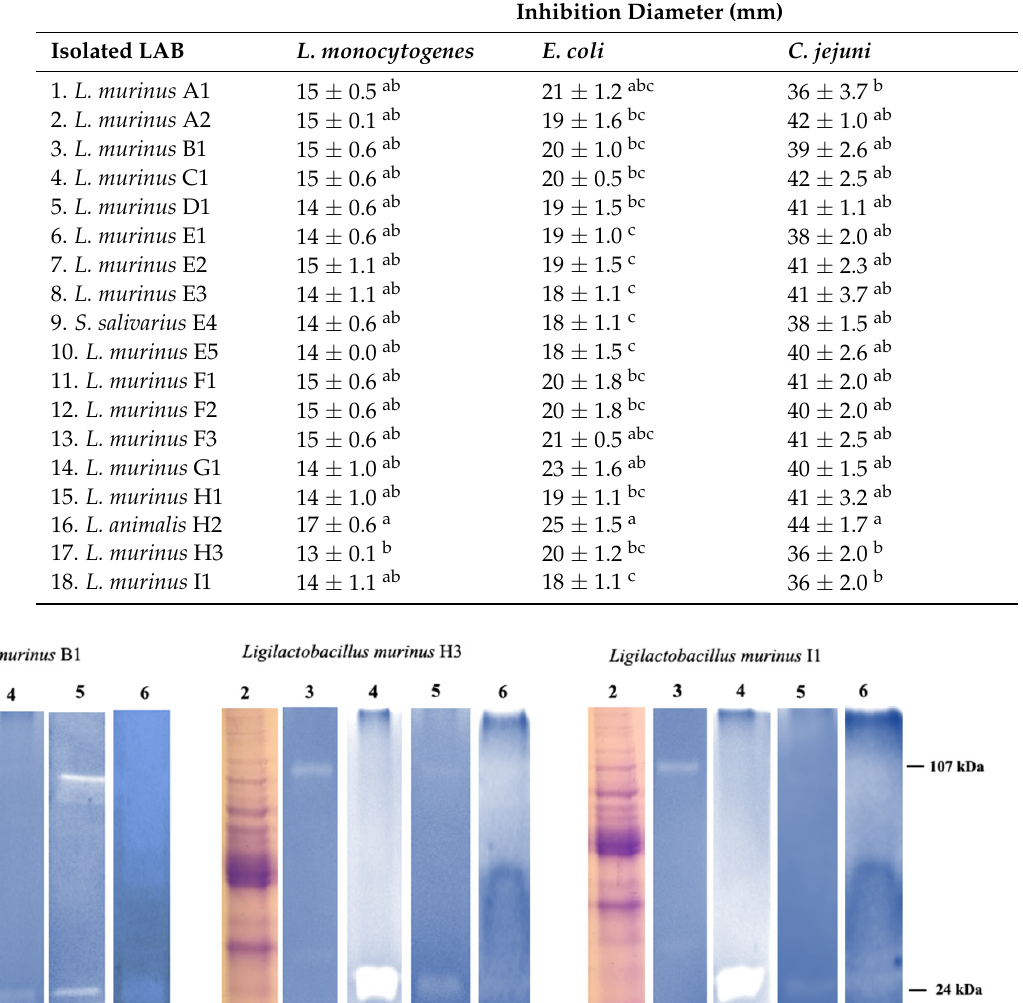
Table 4. Inhibition halos on isolated LAB strain agar plates (mm). Data are expressed as means and standard deviation. abc for columns indicates a significant difference (Tukey).